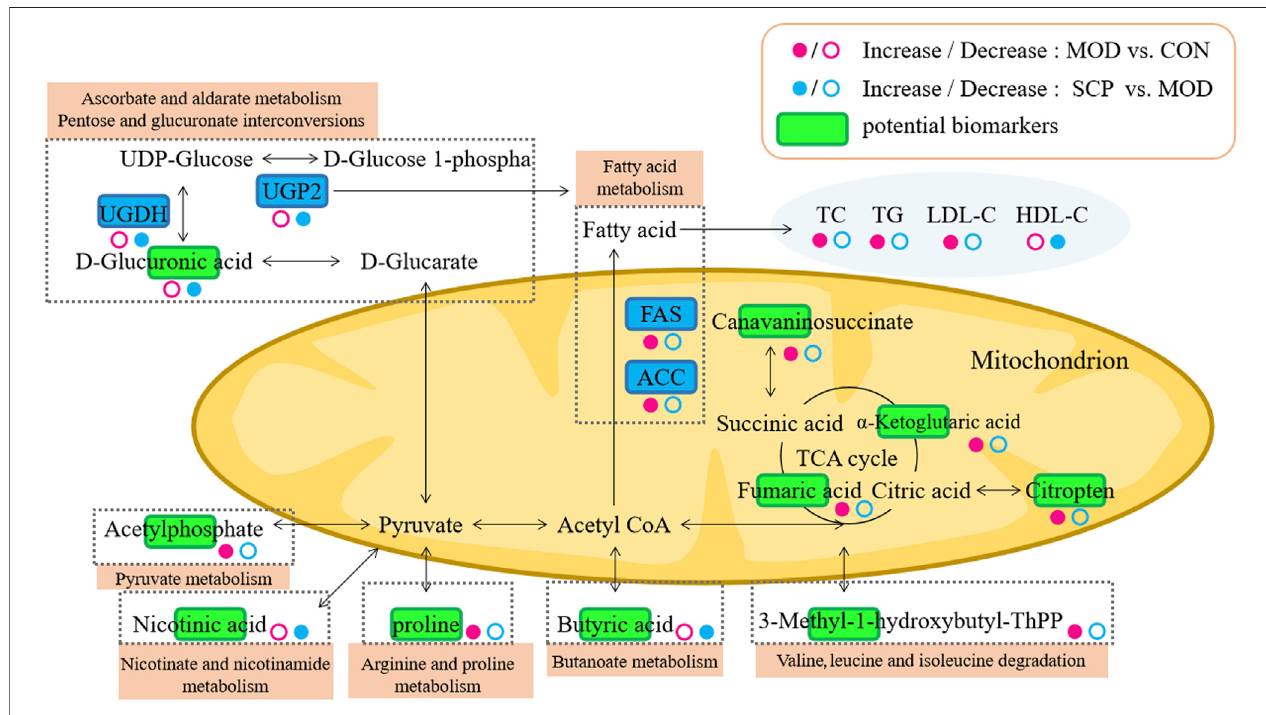
FIGURE 10 | Proposed metabolic pathways regulated by SCP in